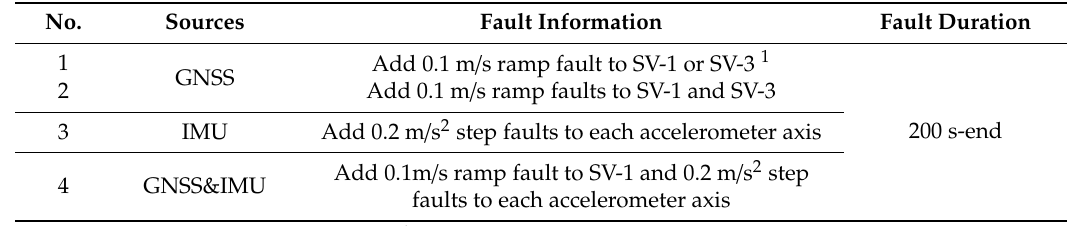
Table 5. Fault scenarios in the